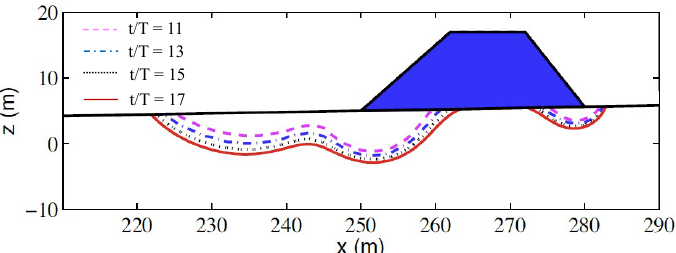
Figure 10. The development of the liquefaction zone in the vicinity of the breakwater (adapted from Zhao and Jeng